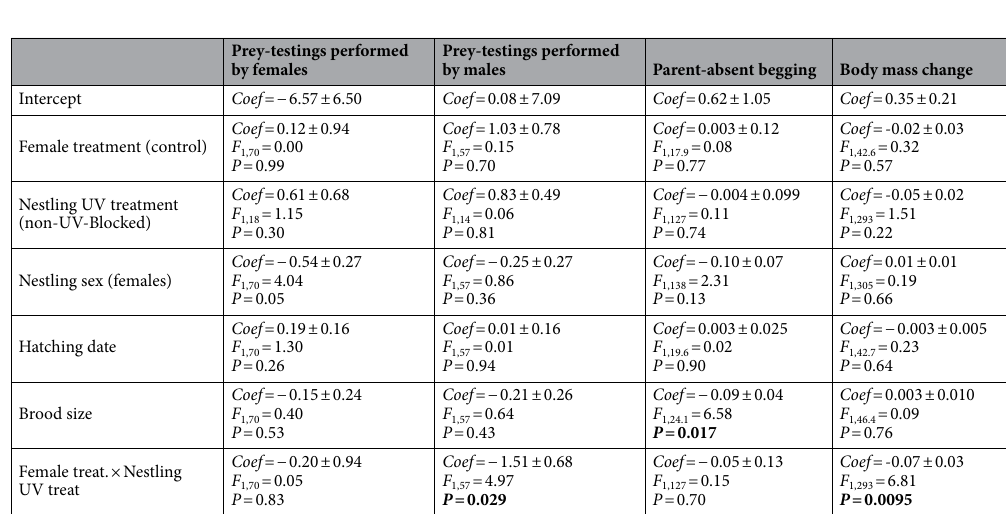
Table 2. Mixed models showing the effects of nestling UV treatment (non-UV-blocked/UV-blocked feather colouration) and female treatment at laying (control/lutein-supplemented) on the number of prey-testings performed by parents, the parent-absent begging intensity and the (log) body mass change. Coefficients are shown for control nests, non-UV-blocked nestlings and females. Significant differences are marked in bold. In Supplementary material, we show the mixed model of body mass change (not log transformed).